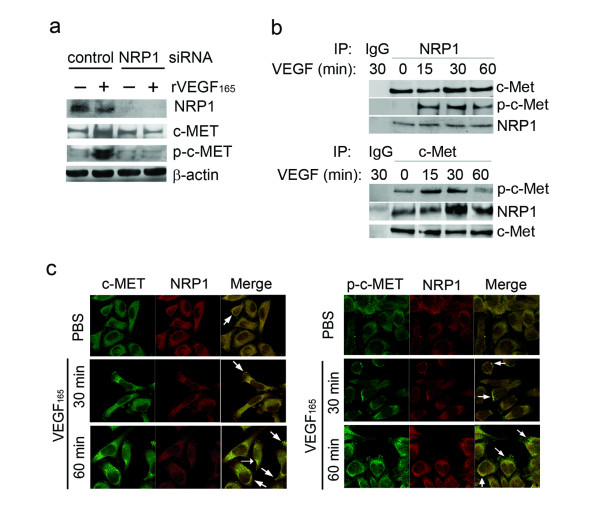
VEGF165 induces c-MET activation through a NRP1-dependent mechanism. (a) Effects of NRP1 depletion on VEGF165-mediated c-MET phosphorylation. ARCaPM cells were transfected with NRP1 siRNA or control siRNA for 48 h, serum-starved overnight, then treated with VEGF165 (10 ng/ml) for 60 min. (b) Immunoprecipitation assay of NRP1-c-MET interaction. Serum-starved ARCaPM cells were treated with VEGF165 (10 ng/ml) for the indicated times, and immunoprecipitated with anti-NRP1 (upper), or anti-c-MET (low) antibody. (c) Co-localization of NRP1 and c-MET or p-c-MET. Serum-starved ARCaPM cells were treated with VEGF165 (10 ng/ml) or PBS for the indicated times. Immunofluorescence staining of NRP1, c-MET or p-c-MET was performed and visualized by confocal microscopy. Arrows indicate co-localization of NRP1 and c-MET or p-c-MET.